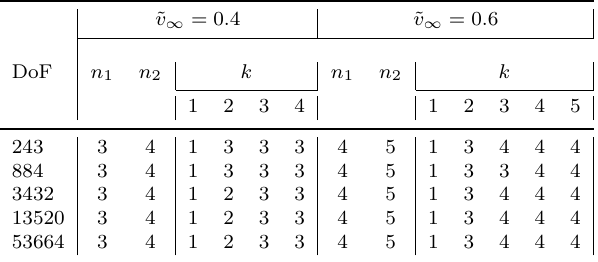
Table 1. The number of required outer ( n 1 , n 2 ) and inner ( k ) iteration steps ˜ v ∞ = 0 .